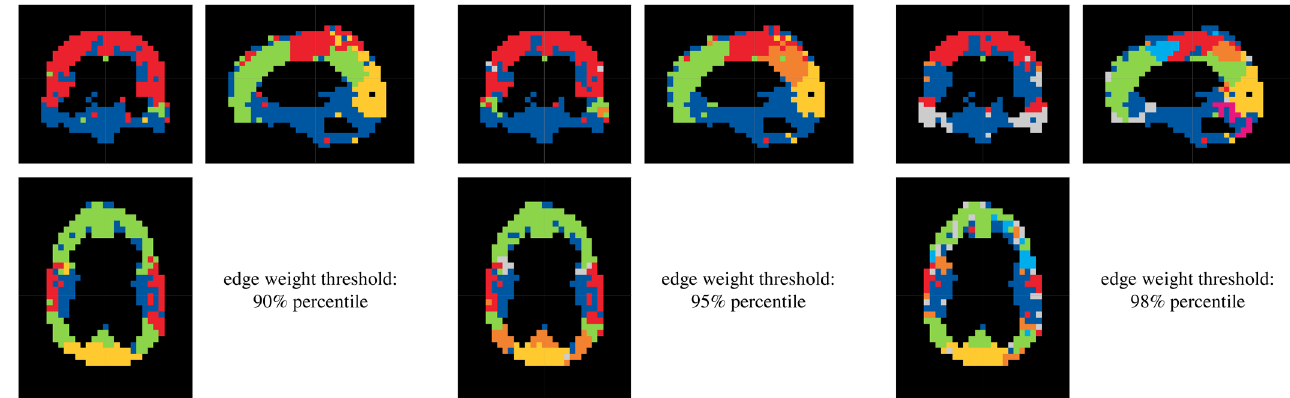
Fig 10. Results of the resting state fMRI functional segmentation for different edge weight distribution percentiles (subject E, 85% variance explanation, “ Louvain ” directed). Each color represents one identified module.